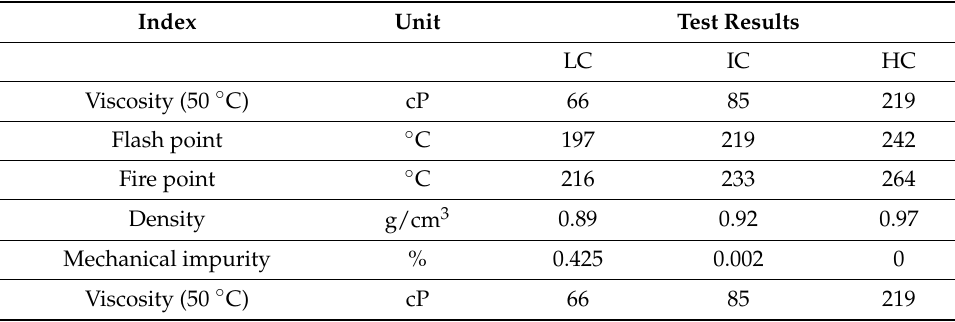
Table 4. Basic performance properties of